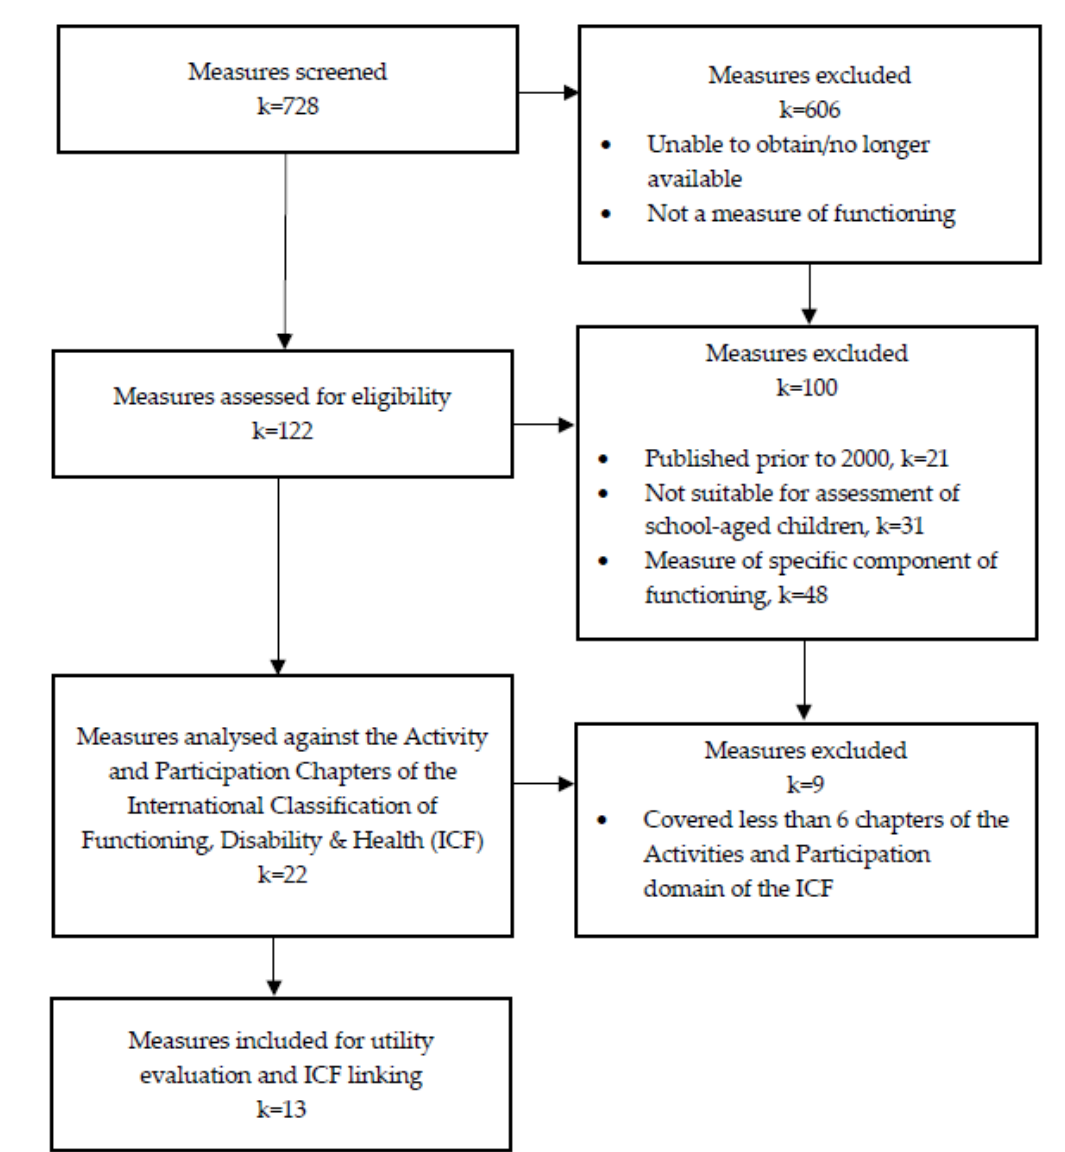
Figure 1. Phase One, study identification and screening process. Table 1. The COnsensus-based Standards for the selection of health Measurement INstruments (COSMIN) definitions of domains and psychometric properties [28] (Note. Adapted from: “COSMIN methodology for systematic reviews of Patient-Reported Outcome Measures (PROMs)” by